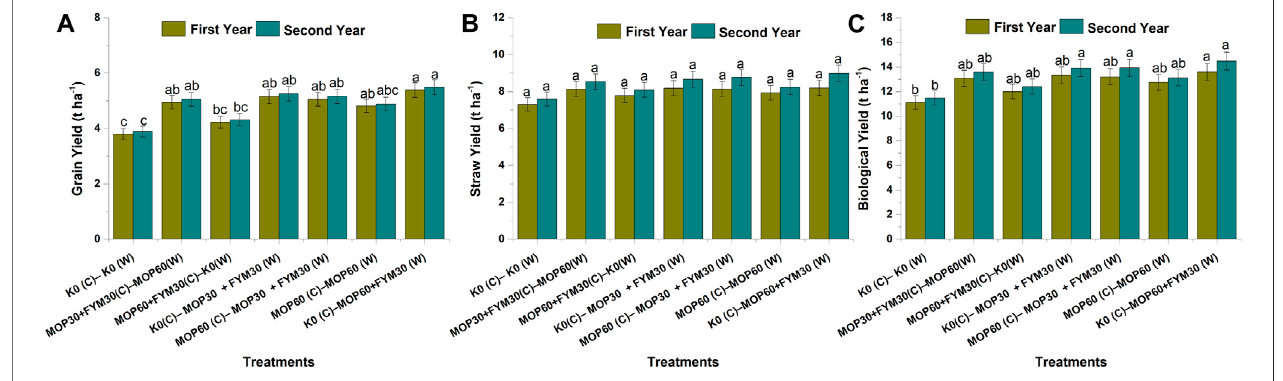
FIGURE 4 | Effect of integrated K application on various yield parameters among treatments: grain yield (A) , straw yield (B) , and biological yield (C) .